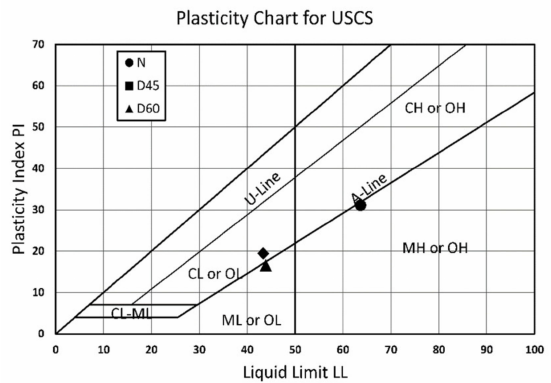
Figure 9. Atterberg limits and soil classification for untreated soil (N) and treated distances of 450 mm (D45) and 600 mm